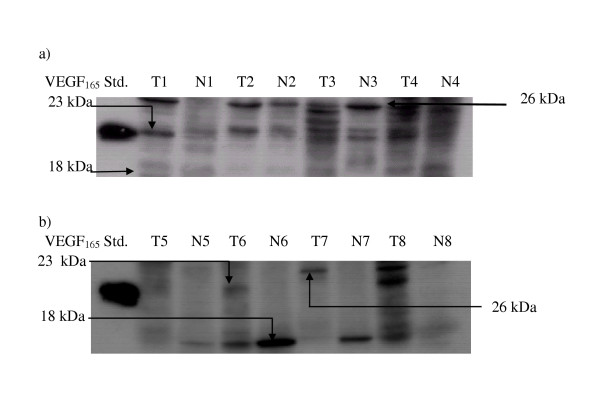
Representative Western blots showing protein expression pattern of VEGF isoform in (a) colorectal and (b) non-small cell lung tumour tissues and their corresponding adjacent normal tissues (T, tumor tissues; N, normal tissues).